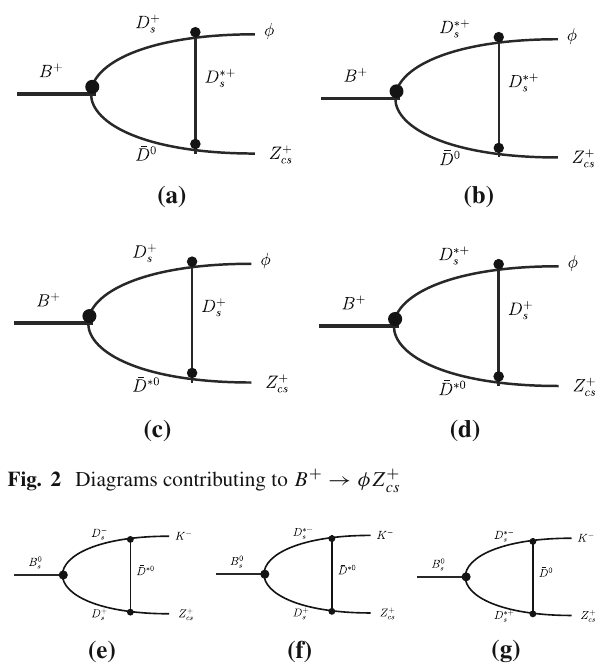
Fig. 3 Diagrams contributing to B 0 s → K − Z + cs the branching ratio of B 0